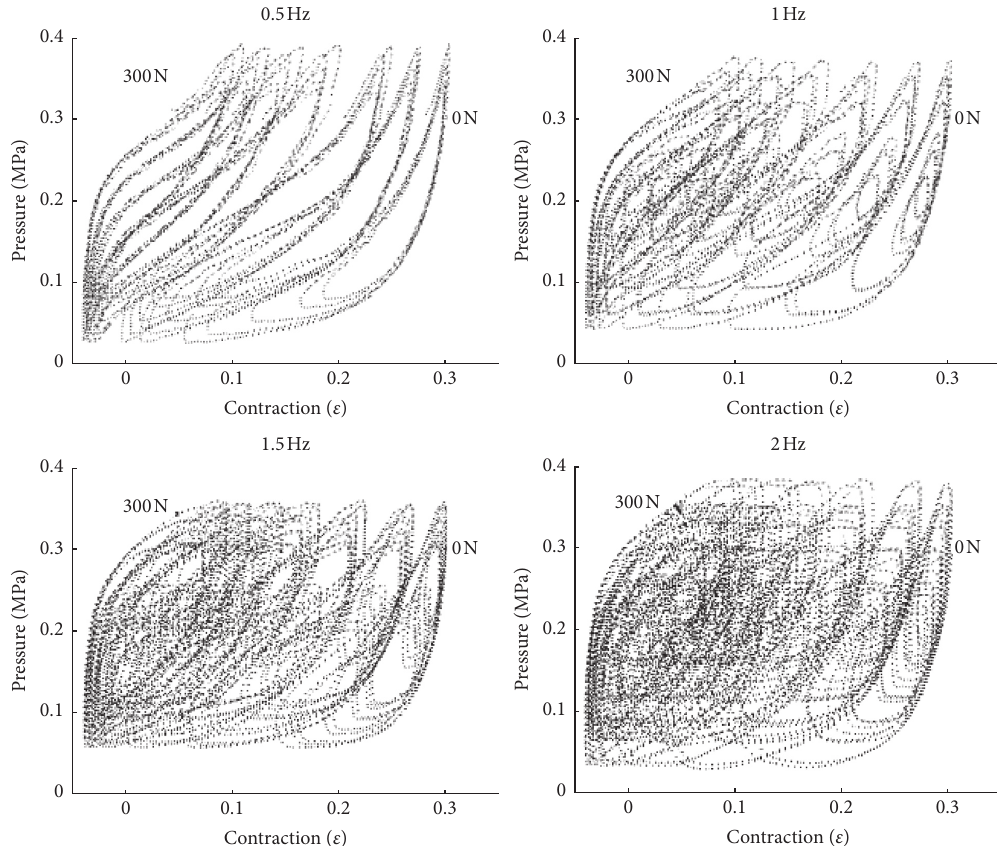
Figure 3: Sample of hysteresis data at various frequencies and external force conditions.